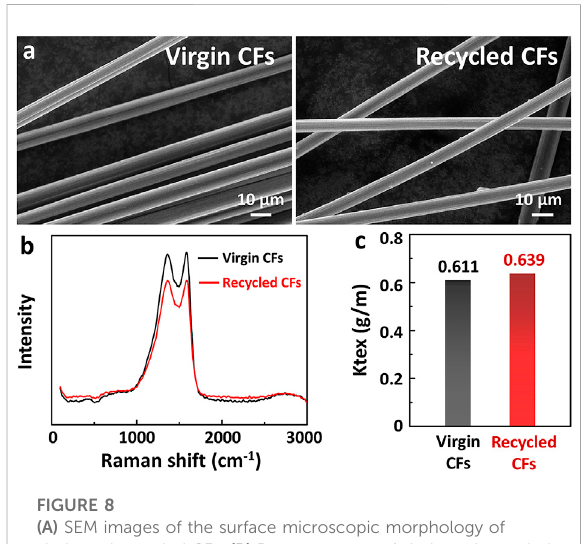
FIGURE 8 (A) SEM images of the surface microscopic morphology